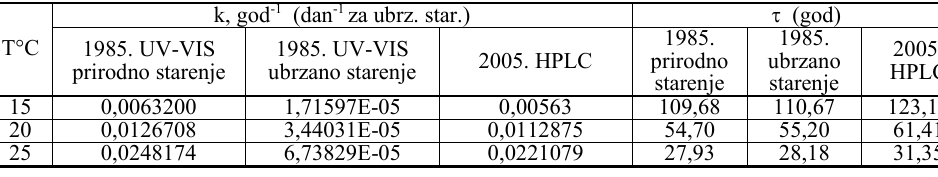
Konstante brzine reakcije utro{ka stabilizatora i vek trajanja baruta NGB-061 k, god -1 (dan -1 za ubrz.